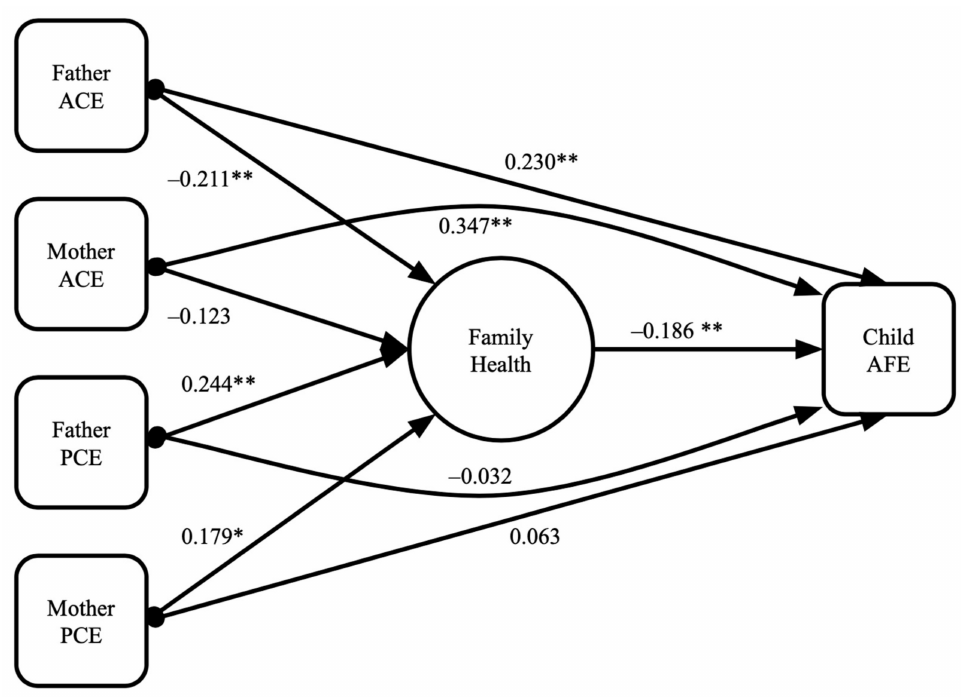
Figure 1. Structural equation model: Parental ACE and PCE associations with family health and